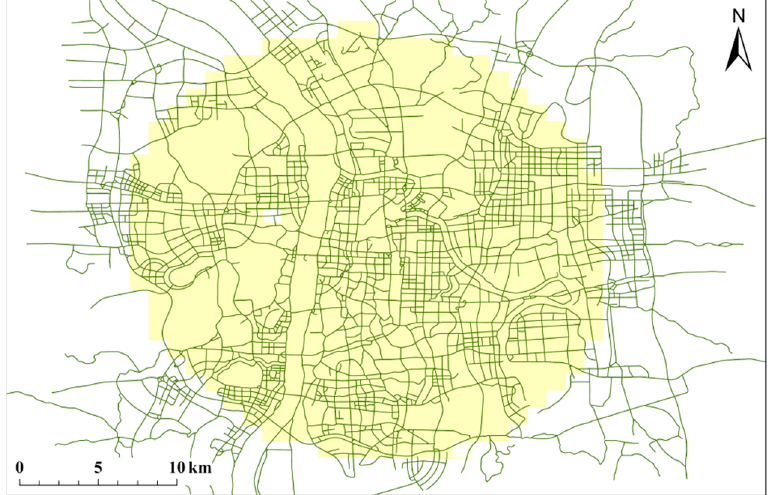
Figure 1. Selected area for case study (yellow zone) [28].